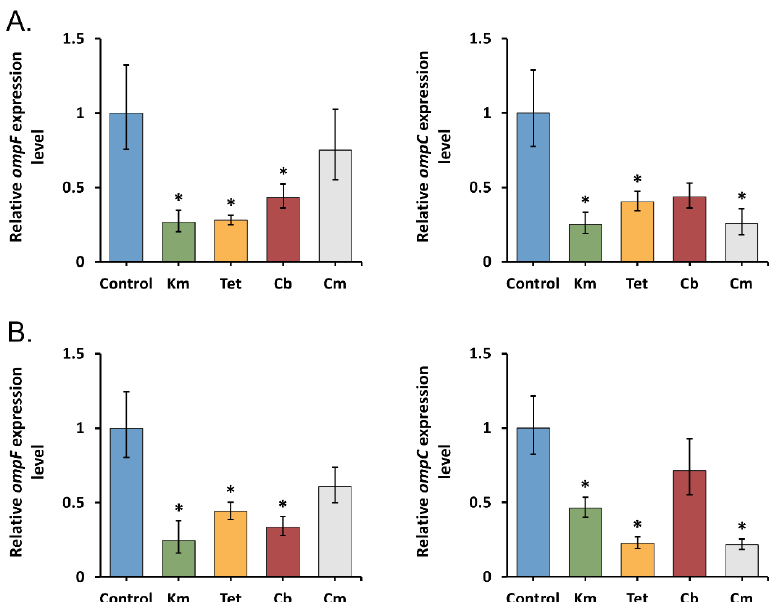
Figure 1. Relative expression levels of Y. pseudotuberculosis ompF and ompC after short-term antibiotic exposure detected by qRT-PCR. ( A ) 27 °C incubation temperature; ( B ) 37 °C incubation temperature. All results are expressed as mean ± standard deviation from three independent experiments. An asterisk indicates p -value < 0.05 vs. respective untreated control. Significance was calculated using one-way ANOVA. Km — kanamycin, Tet — tetracycline, Cb — carbenicillin, and Cm — chloramphenicol.